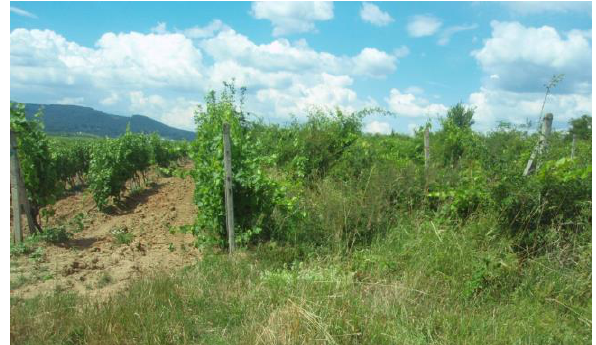
Figure 2. Comparison of a cultivated vineyard (left) with a vineyard overgrown with herbaceous formations